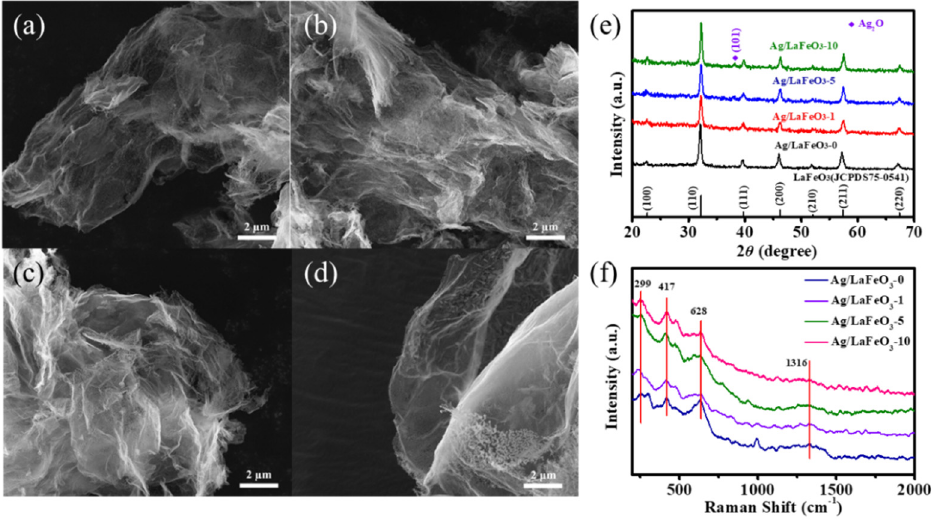
Figure 2. SEM images of ( a ) Ag/LaFeO 3 − 0; ( b ) Ag/LaFeO 3 − 1; ( c ) Ag/LaFeO 3 − 5; ( d ) Ag/LaFeO 3 − 10; ( e ) XRD patterns of the Ag/LaFeO 3 samples with different calcination temperatures; ( f ) Raman spectra of the Ag/LaFeO 3 samples.